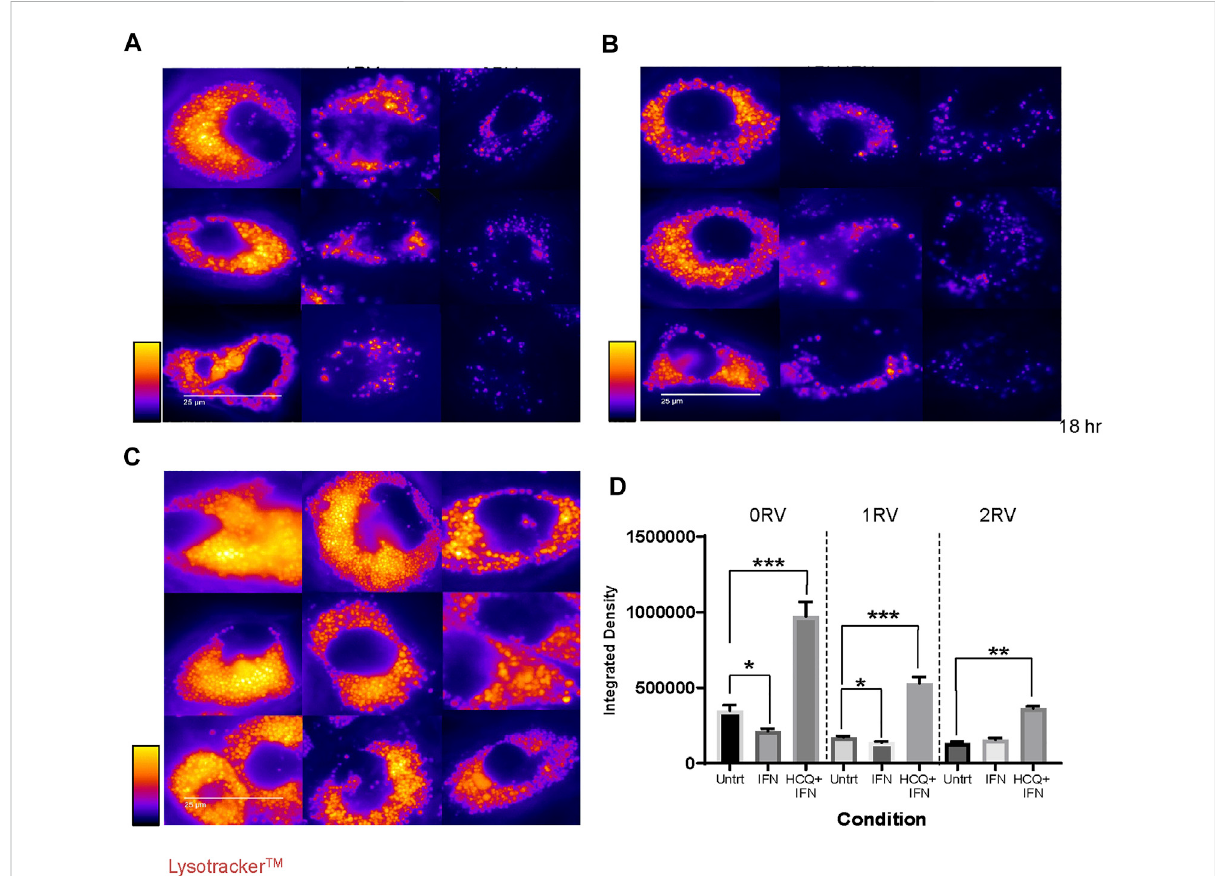
FIGURE 4 Assessment of lysosomal structure in resting and stimulated HUVECs with or without hydroxychloroquine (HCQ) using LysoTracker. AssessmentoflysosomalstructureinrestingandIFN ɣ -exposedorhydroxychloroquineplusIFN ɣ -exposedHUVECsusingLysoTracker,a fl uorescent proxy for lysosomes. Fluorescent micrographs were converted to single channel gray scale, and pseudocolor images representing staining intensity are shown on a continuous scale as depicted by the heat map keys to the left of the images. (A) Immuno fl uorescent images of untreated HUVECs representing each genotype, 0RV (left column), 1RV, and 2RV (right column). (B) Representative images of IFN ɣ 50pg/ml-treated HUVECs across genotype (parallel layout as per A) for 18 h overnight. (C) Representative images of HCQ (25 µM) plus IFN ɣ -treated HUVECs across genotype (layout as per A) LysoTracker staining was performed. Images were captured by fl orescent microscopy using a Nikon Eclipse Ti and representative microphotographswereselected. (D) Theaveragelysosomeintensitypercellregionofinterest(IntegratedDensity)foreachgenotypeandtreatment condition group. N = 1,000 – 1,400 cells per genotype and condition. p -values were calculated using Kruskal – Wallis test for cross genotype comparisons, and Wilcoxon rank sum test for comparing untreated group to the IFN γ treated or HCQ plus IFN γ group.* p < 0.05; ** p < 0.01, *** p <